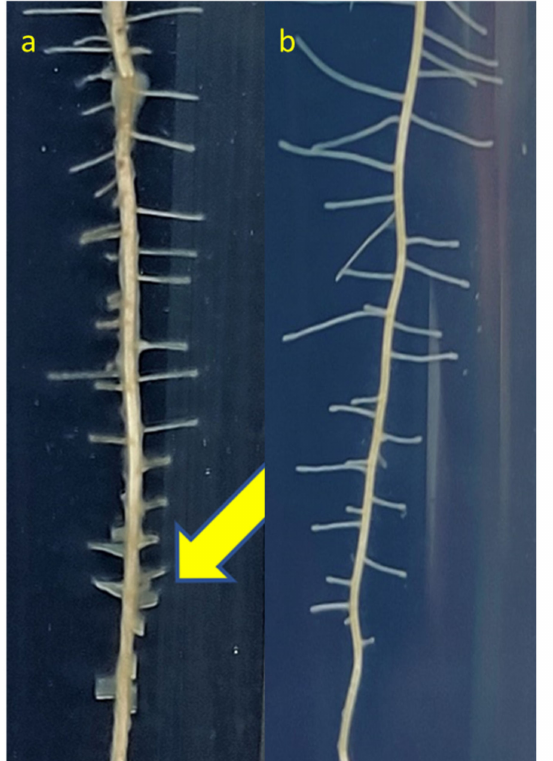
Figure 8. Biofilm formation on roots by Franconibacter helveticus L2C1L2 ( a ); control ( b ). The yellow arrow indicated the biofilm formation around the root by F. helveticus